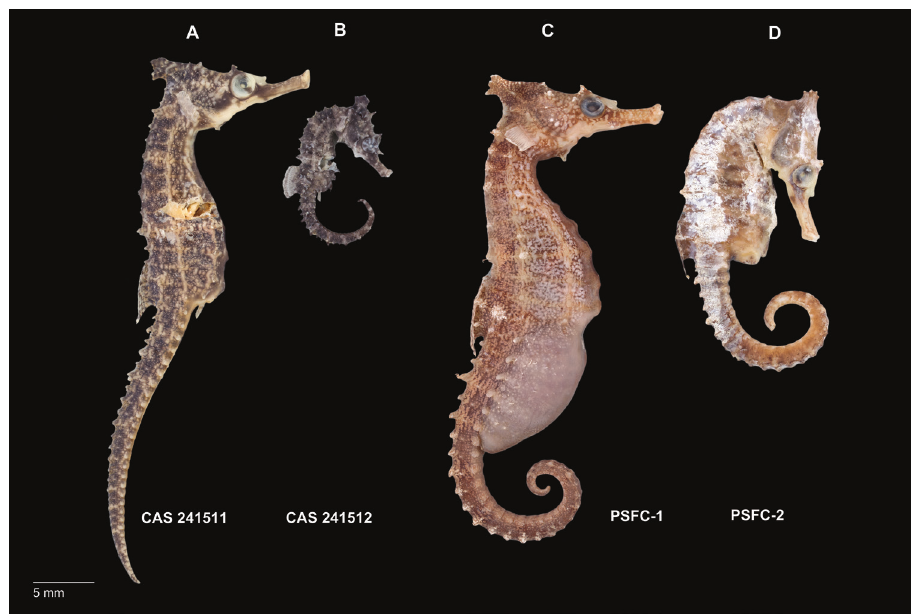
Figure 2. Comparison of non-type specimens of A Hippocampus procerus CAS 241511, preserved adult female, 142.7 mm SL, Southport, QLD B Hippocampus procerus CAS 241512, preserved juvenile, 112.7 mm SL, Southport, QLD 1 Hippocampus whitei PSFC-DH-1, preserved adult male, 122.1 mm SL, Nelson Bay, NSW D Hippocampus whitei CAS PSFC-DH-2, preserved subadult female, 47.7 mm SL, Nelson Bay NSW. Note the differences in coronet profile between juvenile/subadult and adult: projecting anteriad in juvenile/subadult versus lower or projecting posteriorly in